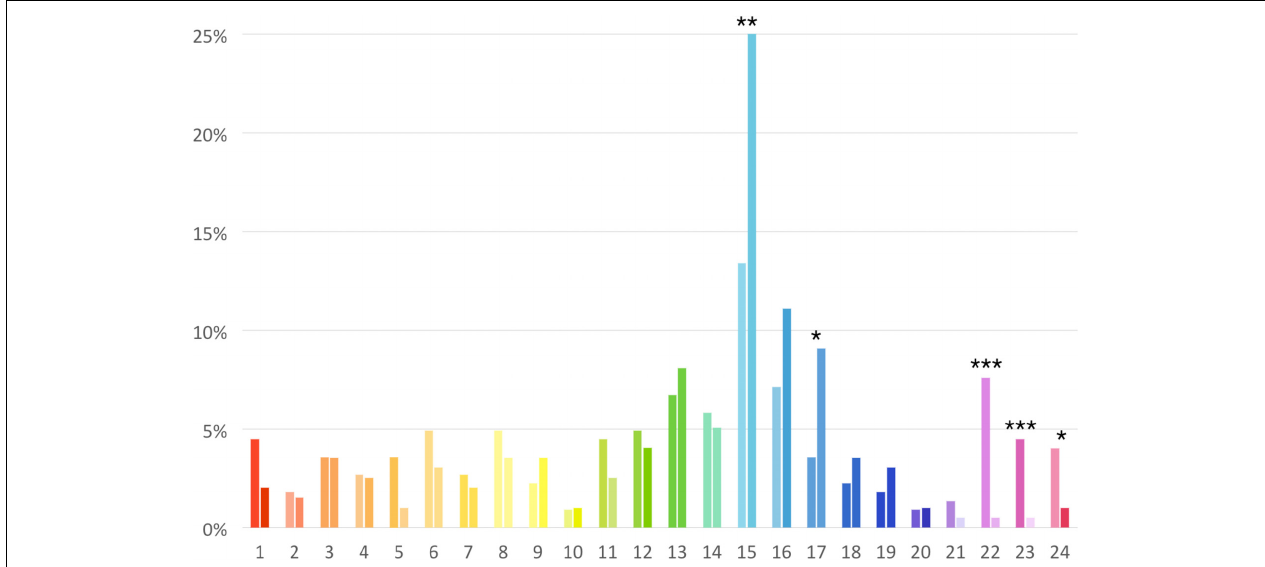
FIGURE 8 | Distribution of the residence hall color preference for males (right bars) and females (left bars) for the 24 hues considered in the study. Lightness level of each bar matches the average preferred lightness level. Asterisks show the significance level for the male-female comparison ( ∗ p < 0.05, ∗∗ p < 0.01, ∗∗∗ p < 0.001).